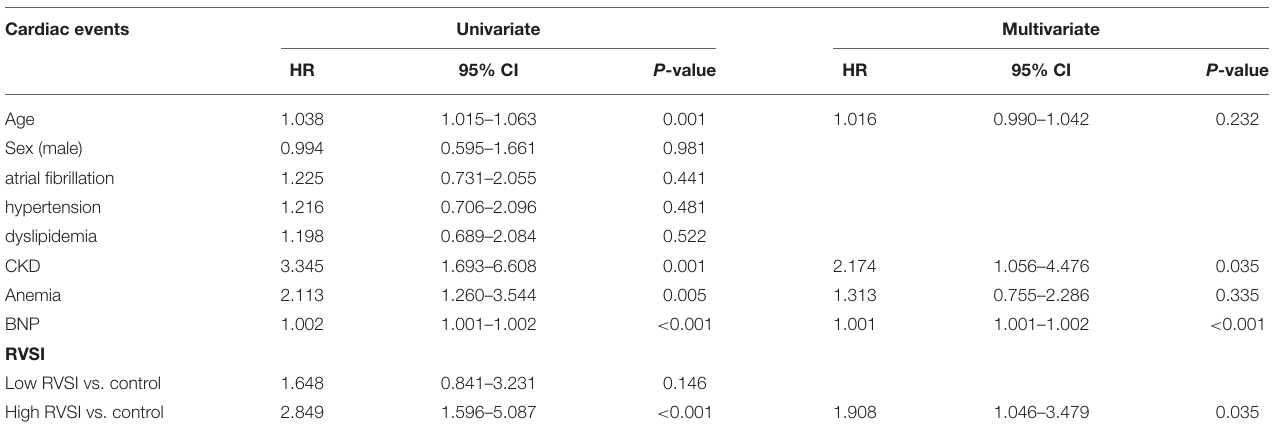
TABLE 2 | Cox proportional hazard model for predicting cardiac events. Cardiac